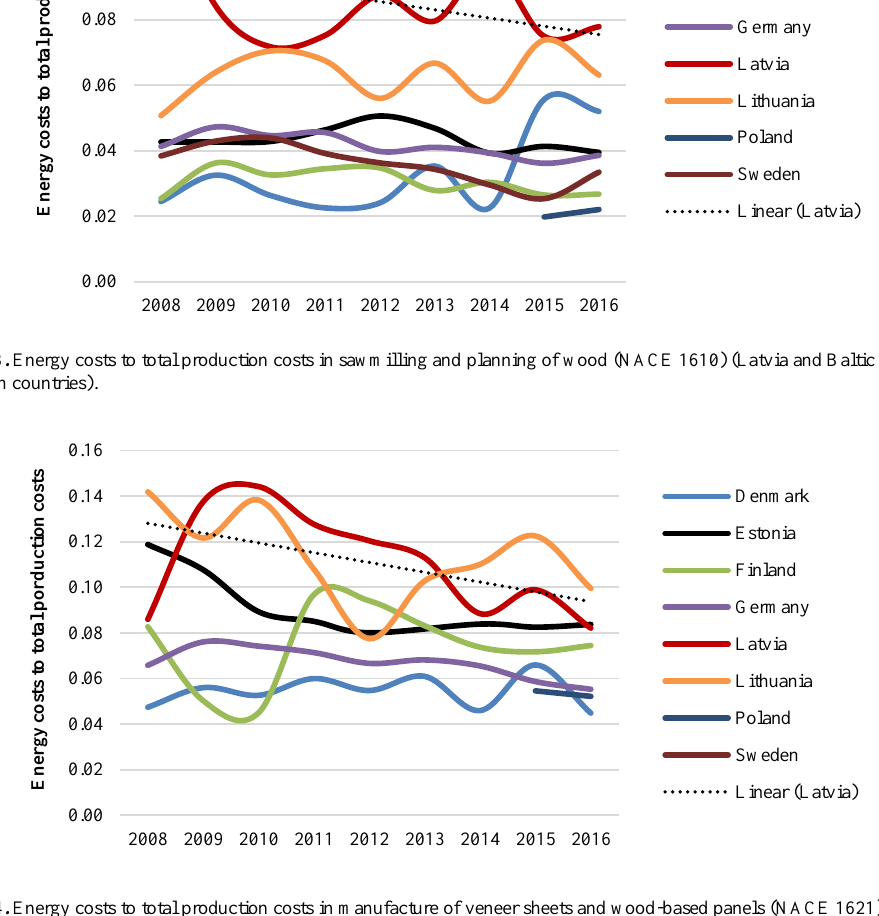
Fig. 4 . Energy costs to total production costs in manufacture of veneer sheets and wood-based panels (NACE 1621) (Latvia and Baltic Sea region countries). Different results are observed when benchmark manufacture of other products of wood; manufacture of articles of cork, straw and plaiting materials (NACE 1629) with peers in other Baltic Sea region countries. The Eurostat SBS data show a huge difference in energy intensity between Latvian companies and their peers from other Baltic Sea region countries (see Fig.